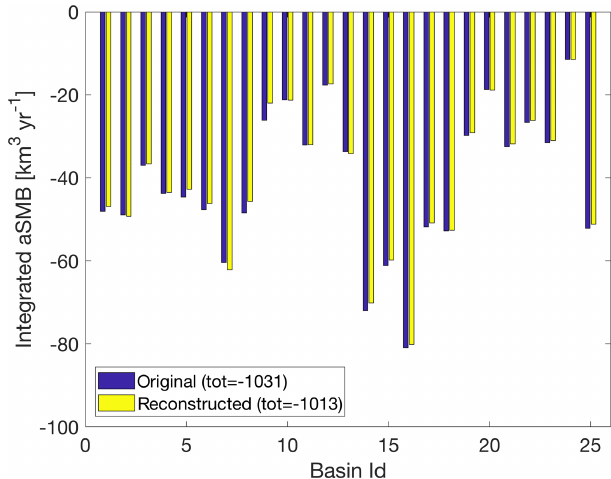
Figure 6. Integrated aSMB per basin from original MAR model output (blue) and for reconstruction on the same geometry (yellow). Greenland-wide total values are given in the